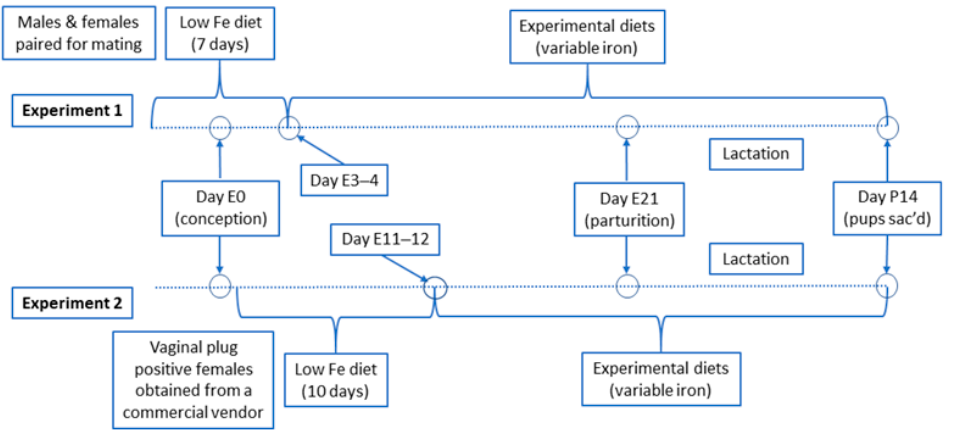
Figure 1. Experimental Design Schematic. Days with an ‘E’ designation indicate embryonic day number (i.e., after conception); ‘P’ indicates postnatal day number (i.e., after birth). The days listed in the diagram are our best estimates, as the exact time/day of conception for each dam is not precisely known. Additionally, note that the litter sizes in experiment 2 were equalized to 8 pups each (to eliminate confounding variables related to the number of suckling pups).